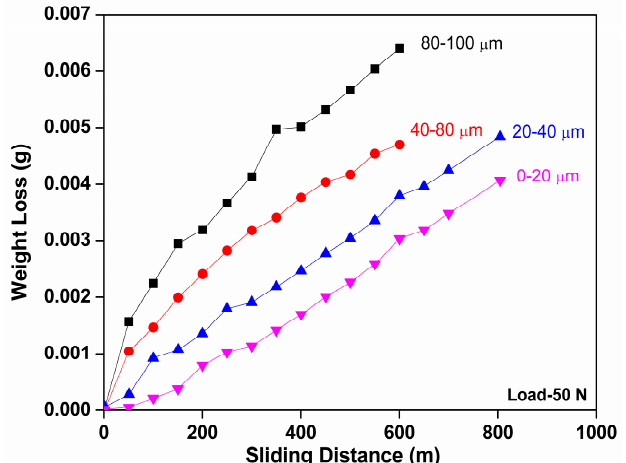
Figure 5. Pin-on-disc experiment showing the mass loss data as a function of sliding distance at a load of 50 N for the composites with different reinforcement size.